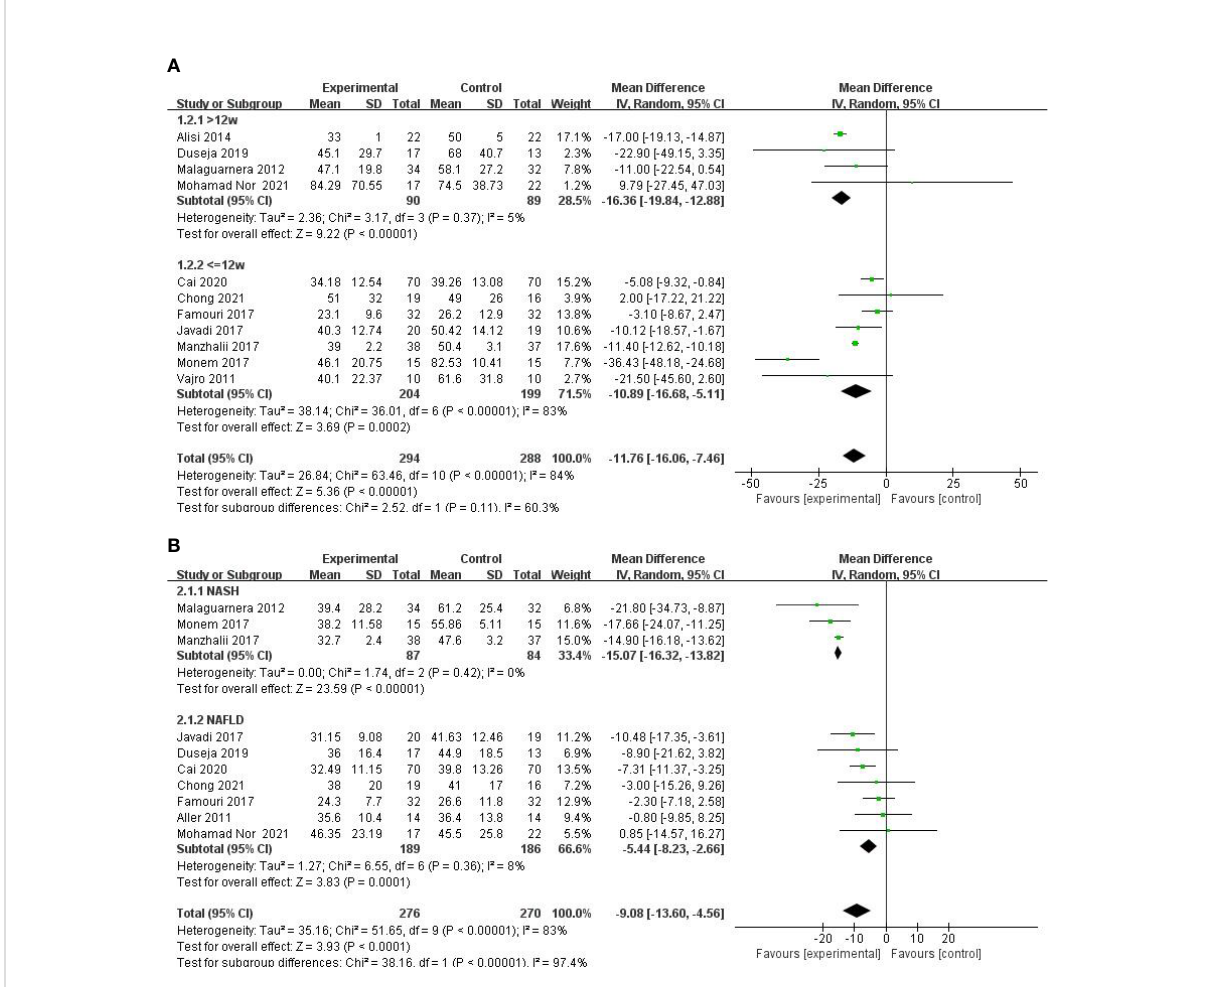
FIGURE 3 Forest plot of the effect of probiotic supplementation on ALT (A) . Forest plot of the effect of probiotic supplementation onAST (B)